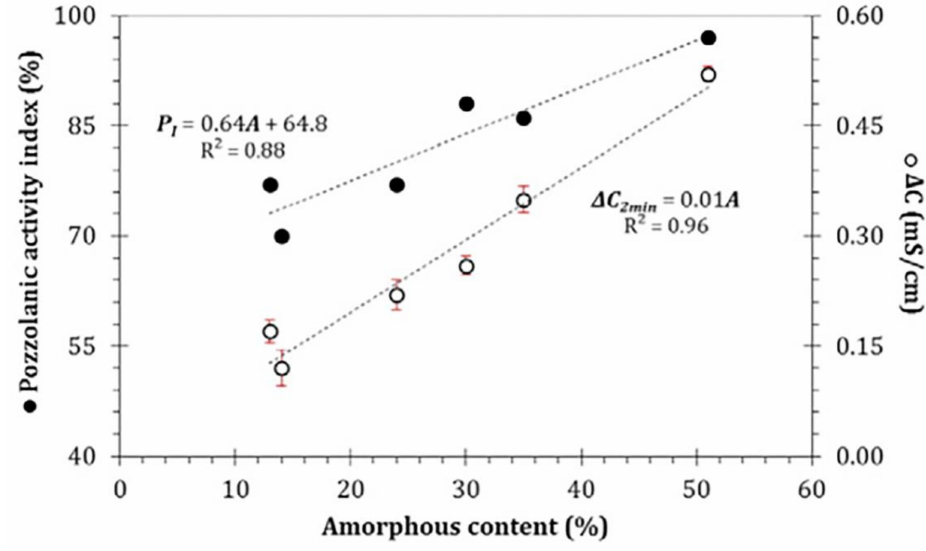
Figure 4. Relationships among conductivity data variation ( ∆ C ), pozzolanic activity index ( P I ) and total amorphous phase content ( A ). Reproduced with permission from